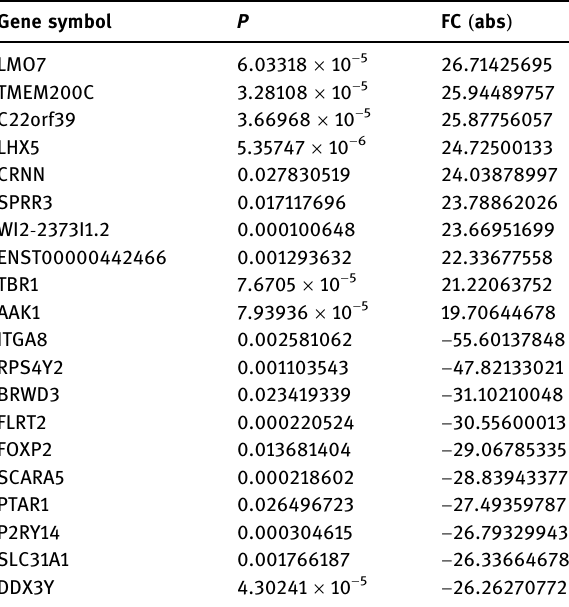
Table 2: The most up - regulated and down - regulated mRNA Gene symbol